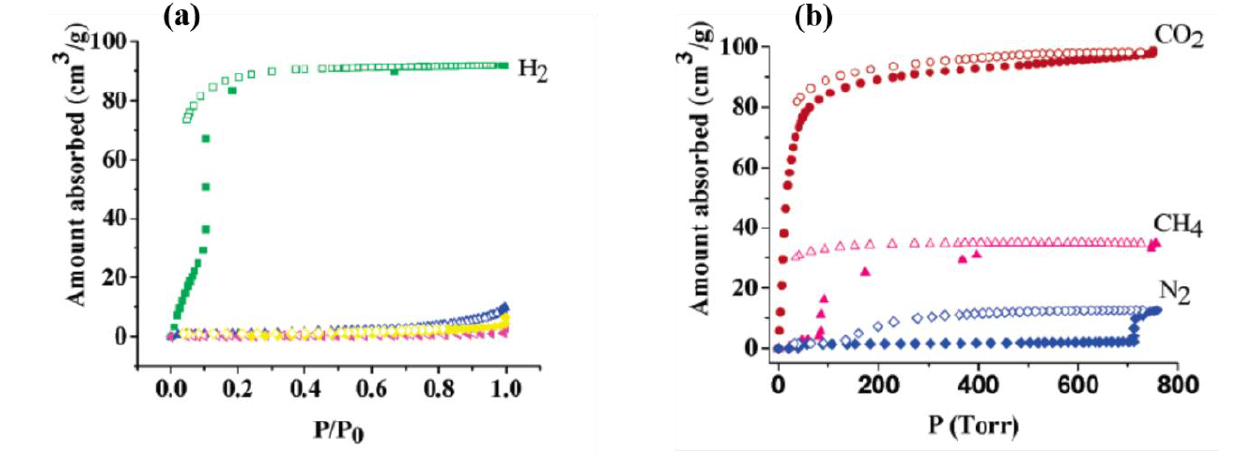
Figure 28. MOF using M The MOF exhibits selective adsorptions towards ( a ) H permission from [154]. Copyright 2007 American Chemical Society.